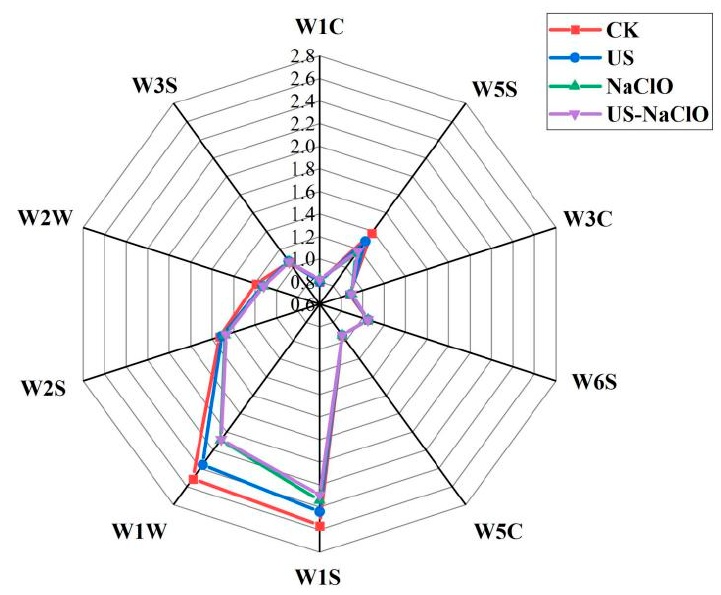
Figure 5. Electronic nose radar plot of the effect of US, NaClO and US-NaClO treatments on the flavor of fresh-cut cucumber on the 8th day of storage.